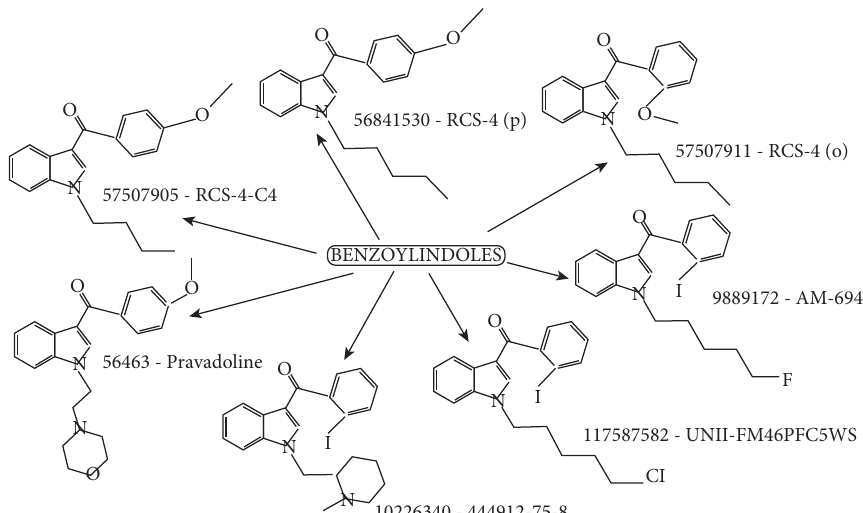
Figure 3: The structures of the molecules from the benzoylindoles group.